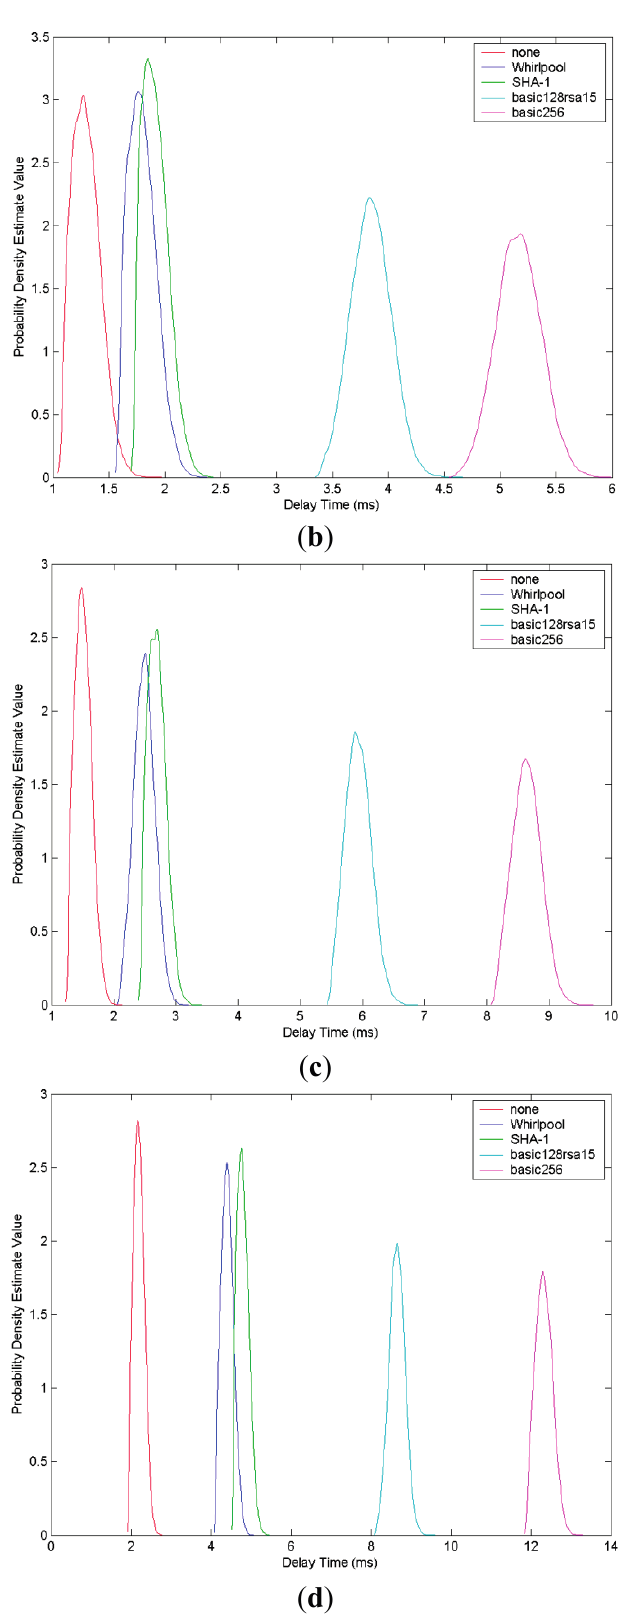
Figure 7. Probability distribution comparison of delay time in different lengths of messages. ( a ) In the length of 1024 bytes; ( b ) In the length of 4096 bytes; ( c ) In the length of 8192 bytes; ( d ) In the length of 16384